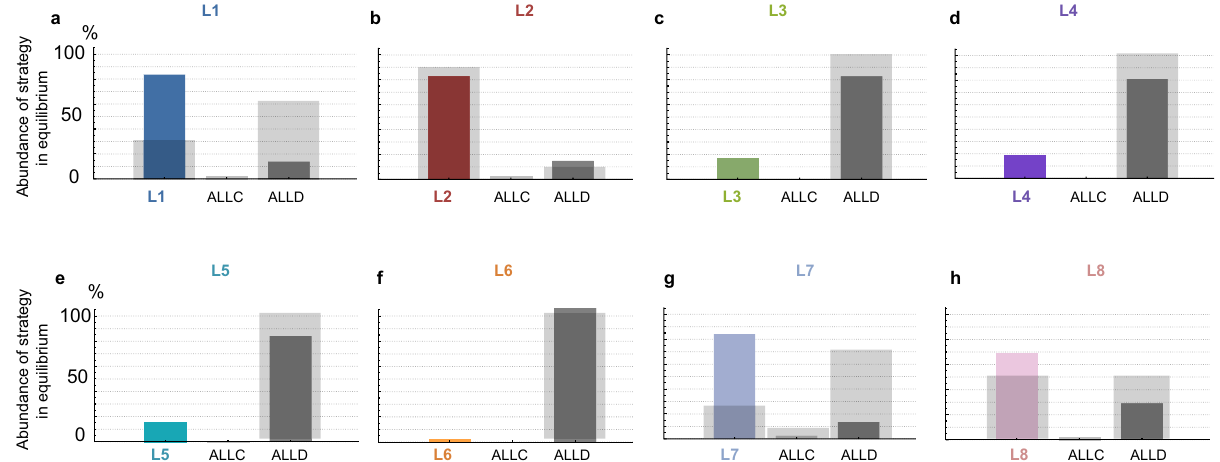
Fig. 6 | Four of the leading eight evolve in high proportions for quantitative assessment. We compare the abundance of the leading eight strategies in selection – mutation equilibrium between the case of quantitative assessment and thebaselinemodel.WeusethesameevolutionaryprocessandsetupasinFig.5and present the changes in how often each norm is played on average. Colored bars represent the abundance in equilibrium under quantitative assessment, while the